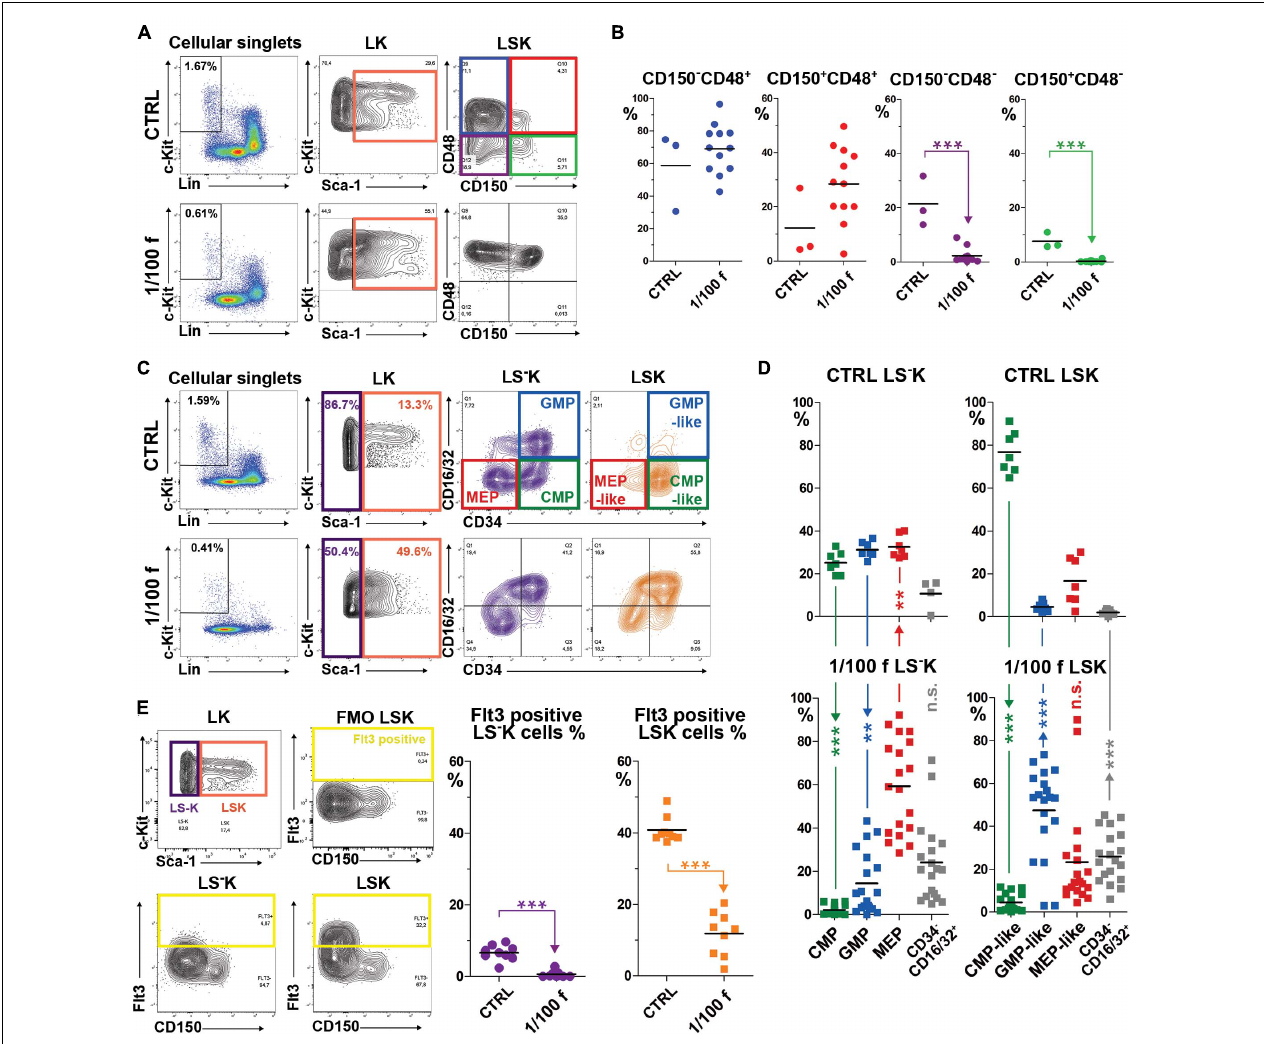
FIGURE 1 | Immature hematopoietic cells in bone marrow regenerating from transplanted cells have significantly altered immunophenotype. (A) The gating of LSK cells with four CD150/CD48 expression profiles according to Kiel et al. (2005). (B) The four subsets of LSK cells with the specific CD150/CD48 expression profile were analyzed in three independent experiments that each included one untreated mouse (CRTL) and a group of four mice irradiated at 9 Gy, transplanted with 1/100 of the syngeneic femoral bone marrow, and examined after 14 days. (C) The gating of the four CD34/CD16-32 expression profiles according to Akashi et al. (2000) in LS − K, but also in LSK cells. (D) LS − K and LSK cells were analyzed for the expression pattern of CD34 and CD16/32 in seven untreated mice (CTRL) and 19 mice transplanted with 1/100 of the syngeneic bone marrow examined after 14 days. Results are pooled from five independent experiments. (E) The gating used to determine Flt3 (CD135)-positive cells in LS − K and LSK cells in nine untreated mice (CTRL) and nine mice transplanted with 1/100 of the syngeneic femoral bone marrow and examined after 14 days. ** p < 0.01, *** p <